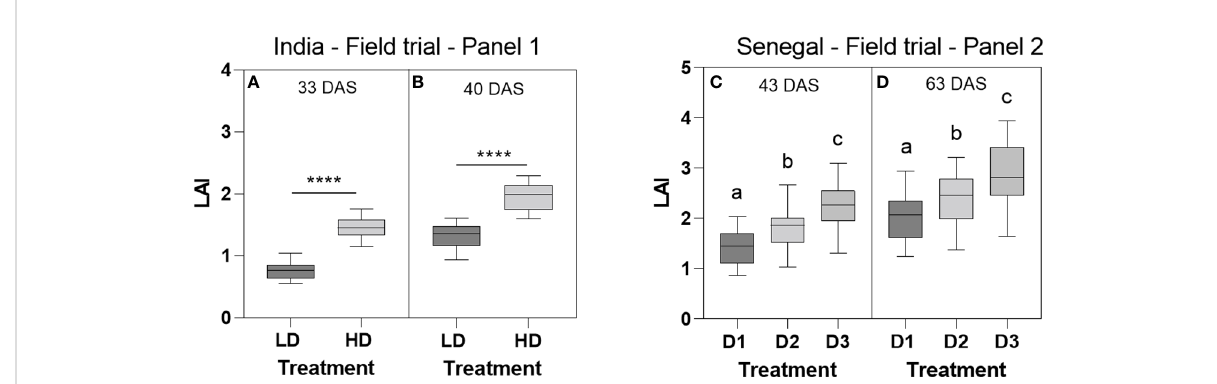
FIGURE 3 Leaf area index (LAI) measured at 33 DAS (A) and 40 DAS (B) in the 2018 fi eld trial in India under low density (LD) and high density (HD), and at 43 DAS (C) and 63 DAS (D) in the 2020 fi eld trial in Senegal in the low (D1, 3.2 plants/m 2 ), intermediate (D2, 6.4 plants/m 2 ), and high (D3, 12.8 plants/ m 2 ) density treatments. Data are means and standard deviation of 20 genotypic means in India and 30 genotypic means in Senegal. Genotypic mean values were the average of 4 replicated plots in India and 3 replicated plots in Senegal, for each genotype-by-density combination. ****, p-value